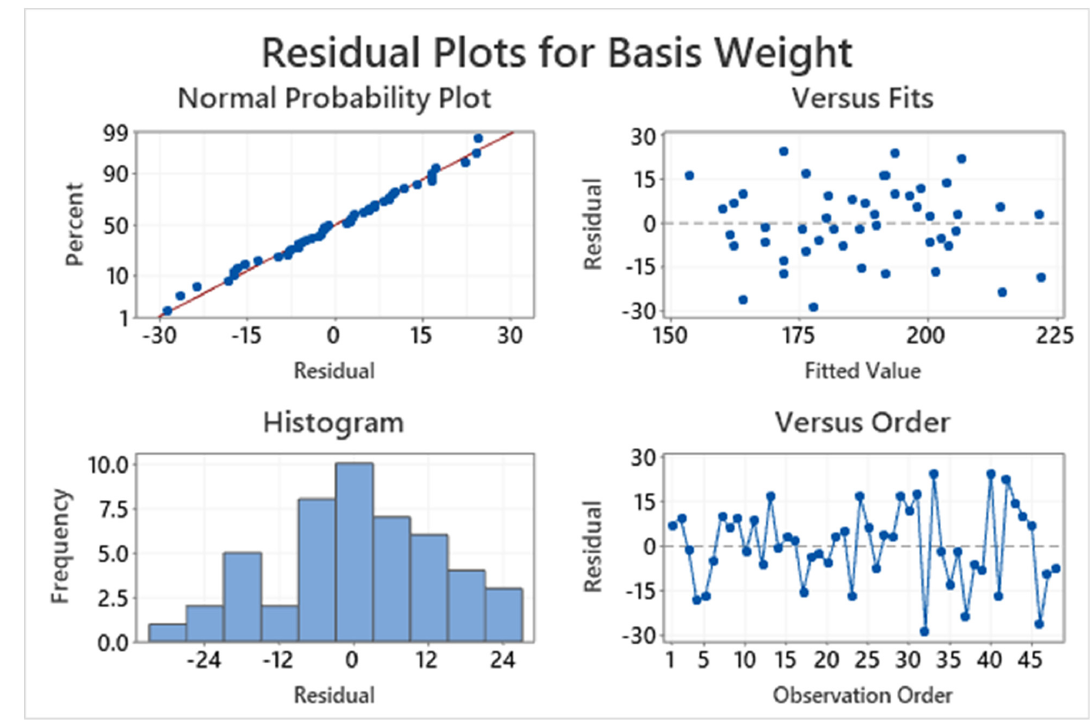
Figure 6. Model assumptions for experimental designs. Table 3. Analysis of variance.